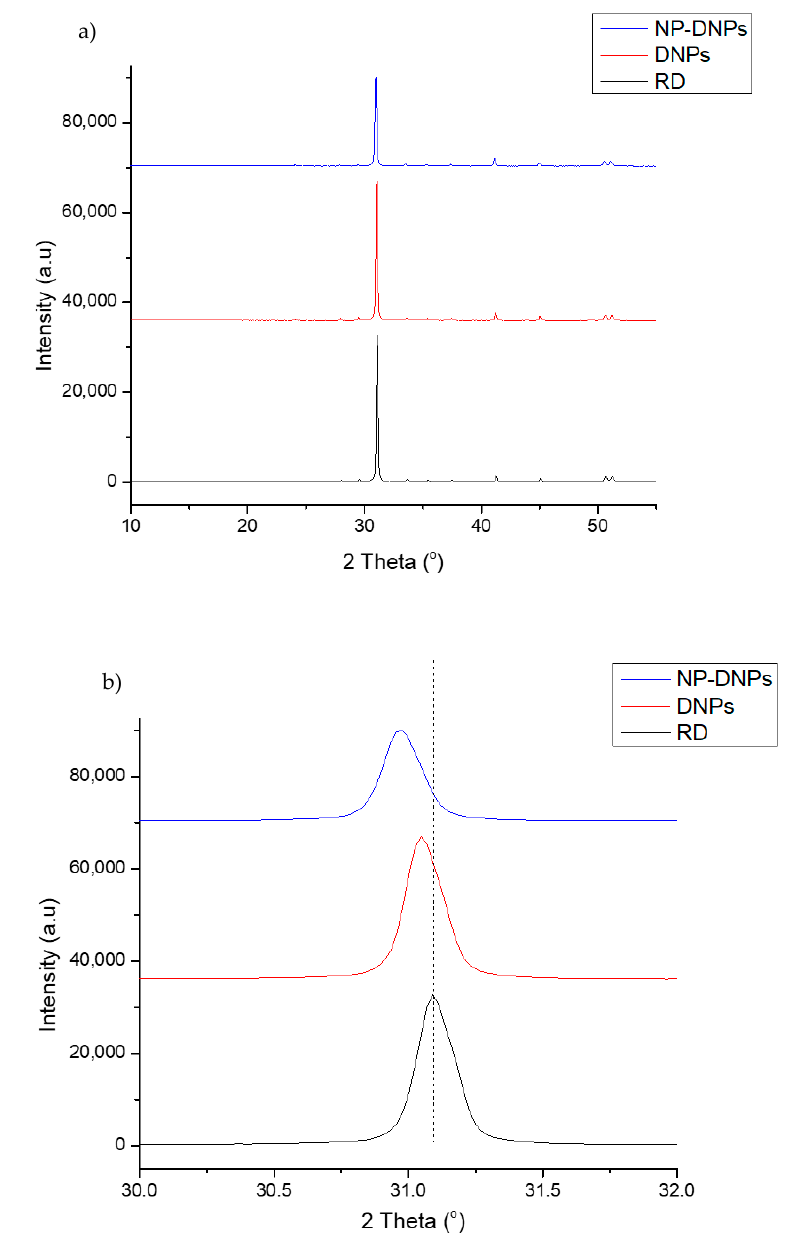
Figure 8. X-ray diffraction pattern of raw dolomite (RD), dolomite nanoparticles (DNPs), and non- polar dolomite nanoparticles (NP-DNPs) that focus on the 2 theta ranges between ( a ) 10° and 55° and ( b ) 30° and 32° .